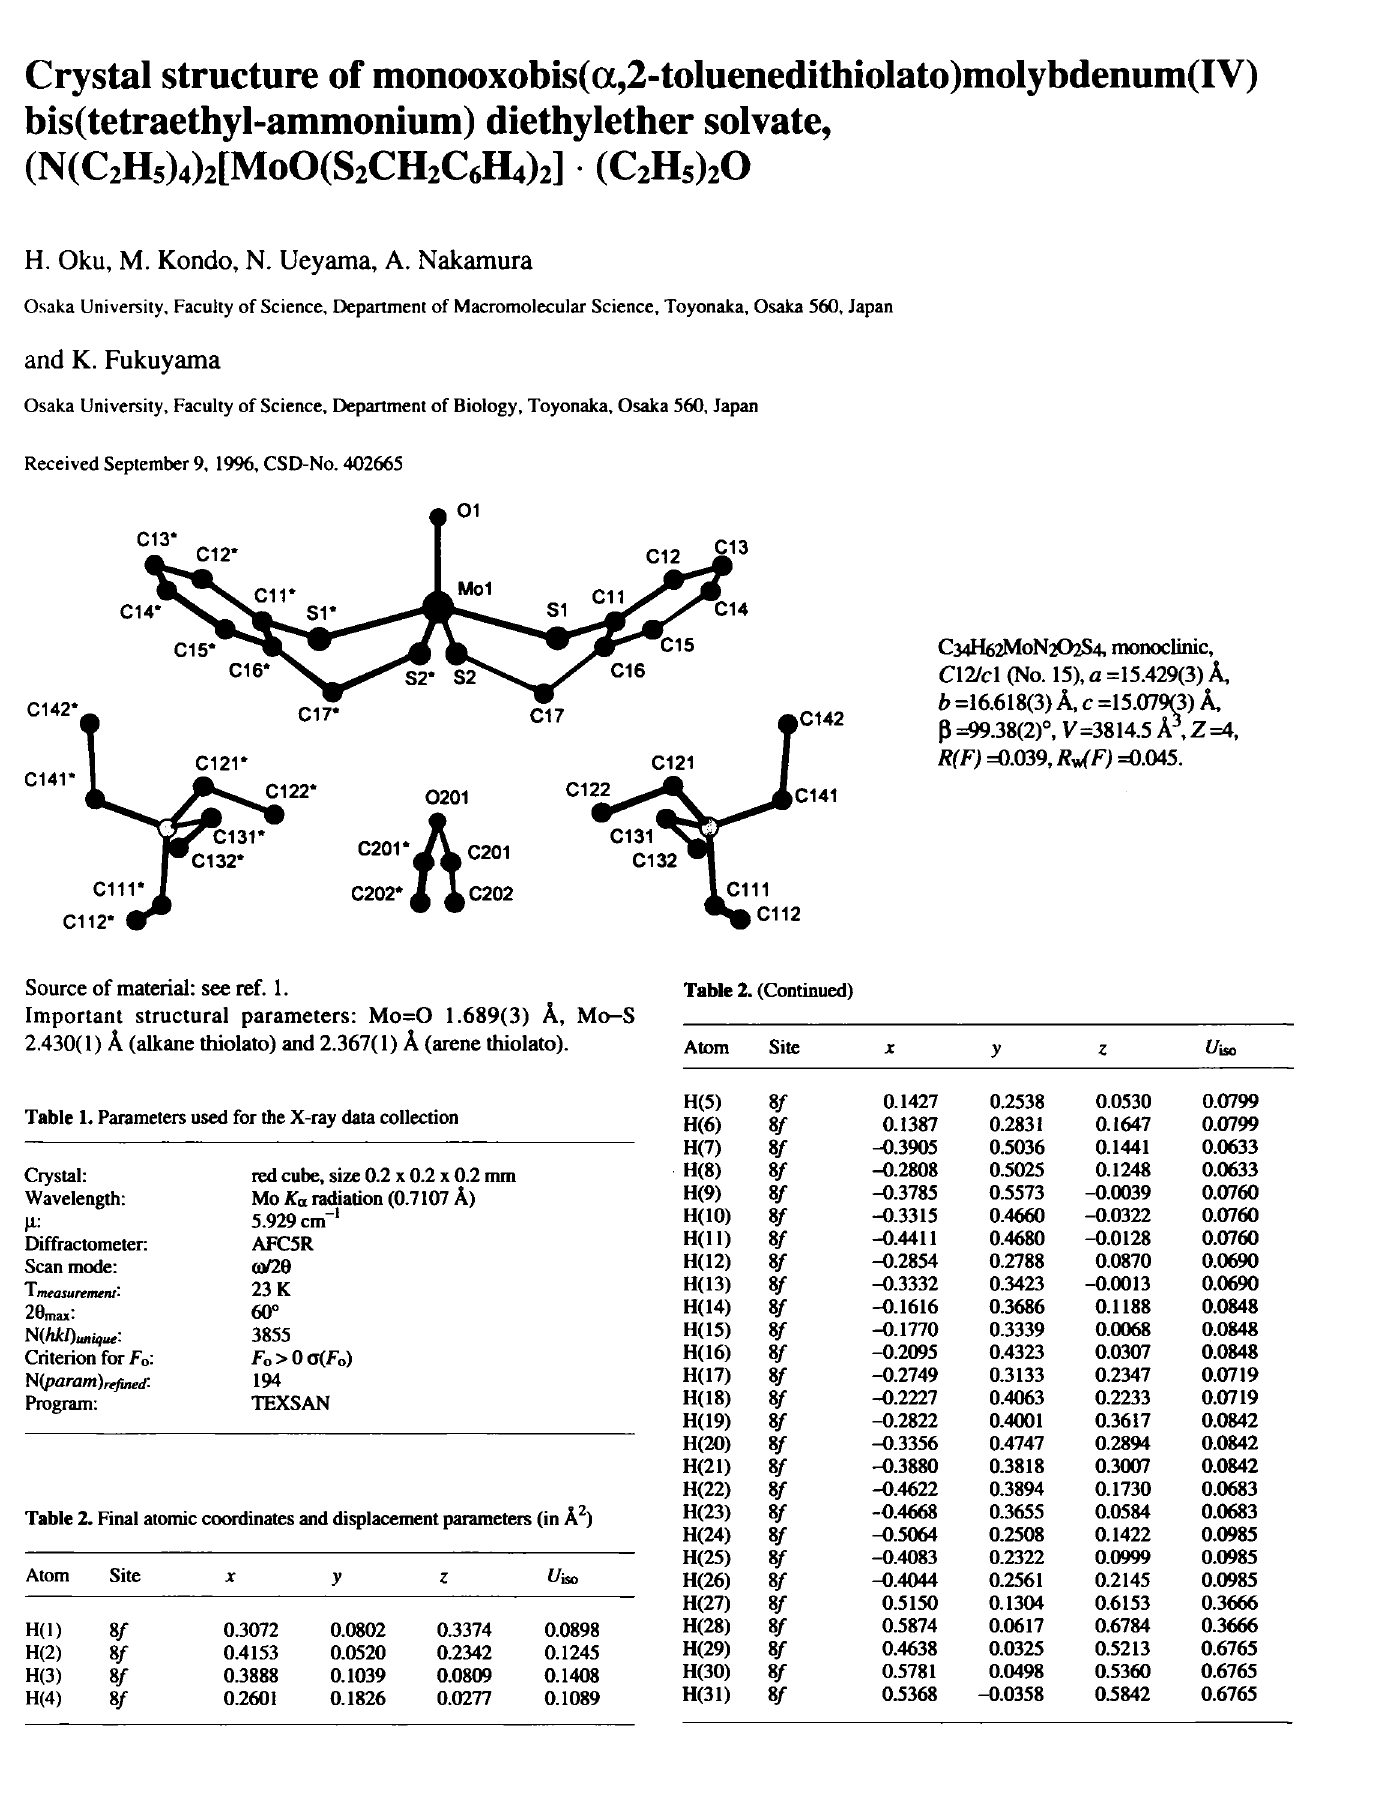
Table 1. Parameters used for the X-ray data collection Crystal: